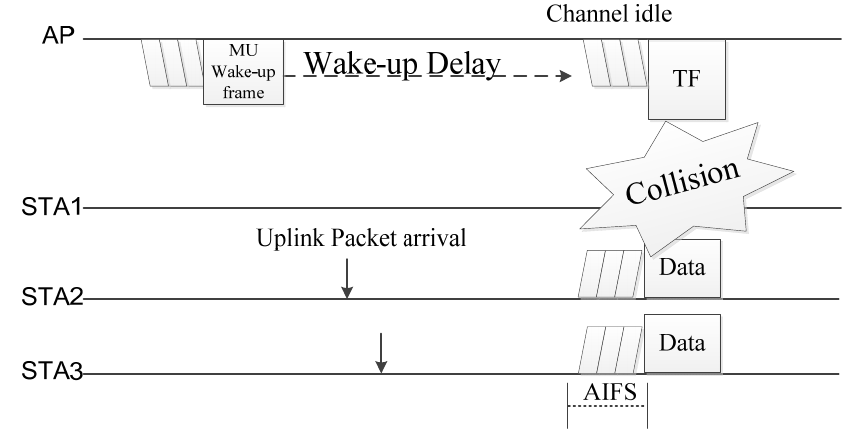
Figure 12. Collision case in multiuser wake-up procedure. MU = multi-user; AIFS = arbitration inter-frame spacing.